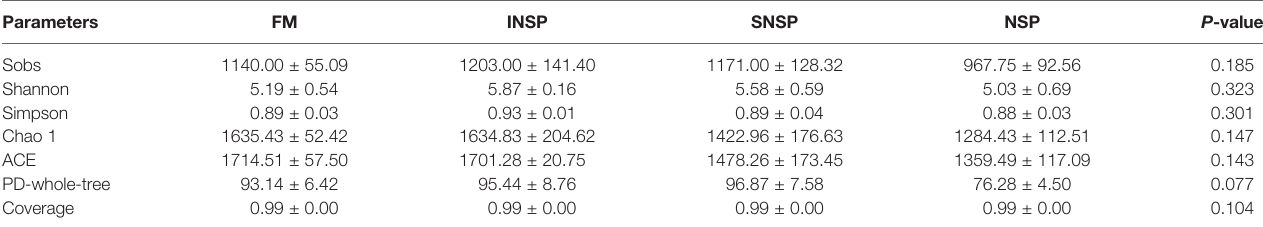
TABLE 9 | Effects of experimental diets on Alpha diversity of intestinal fl ora in GIFT tilapia. Parameters